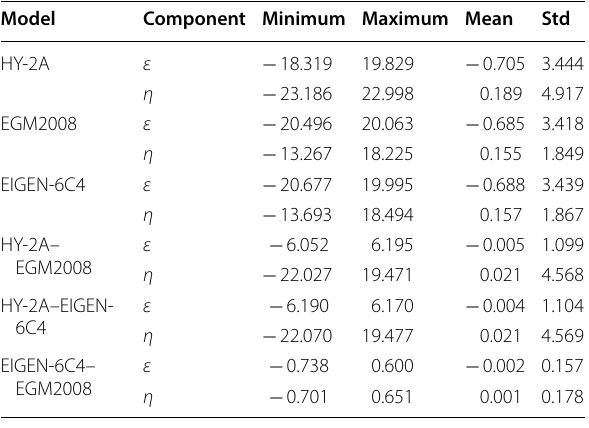
Table 3 Summary statistics of components of vertical deflection (unit: seconds) Model